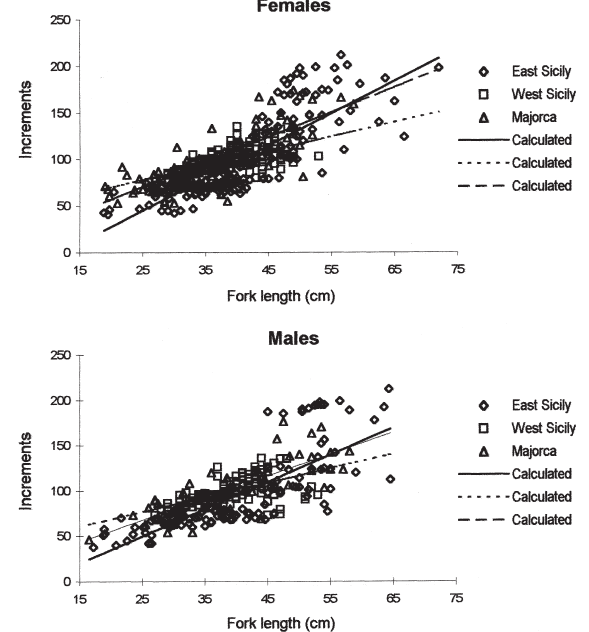
F IG . 5. – Relationship between fork length and the number of incre- ments for both study areas and for sagittae (Majorca and eastern Sicily) and lapilli (western